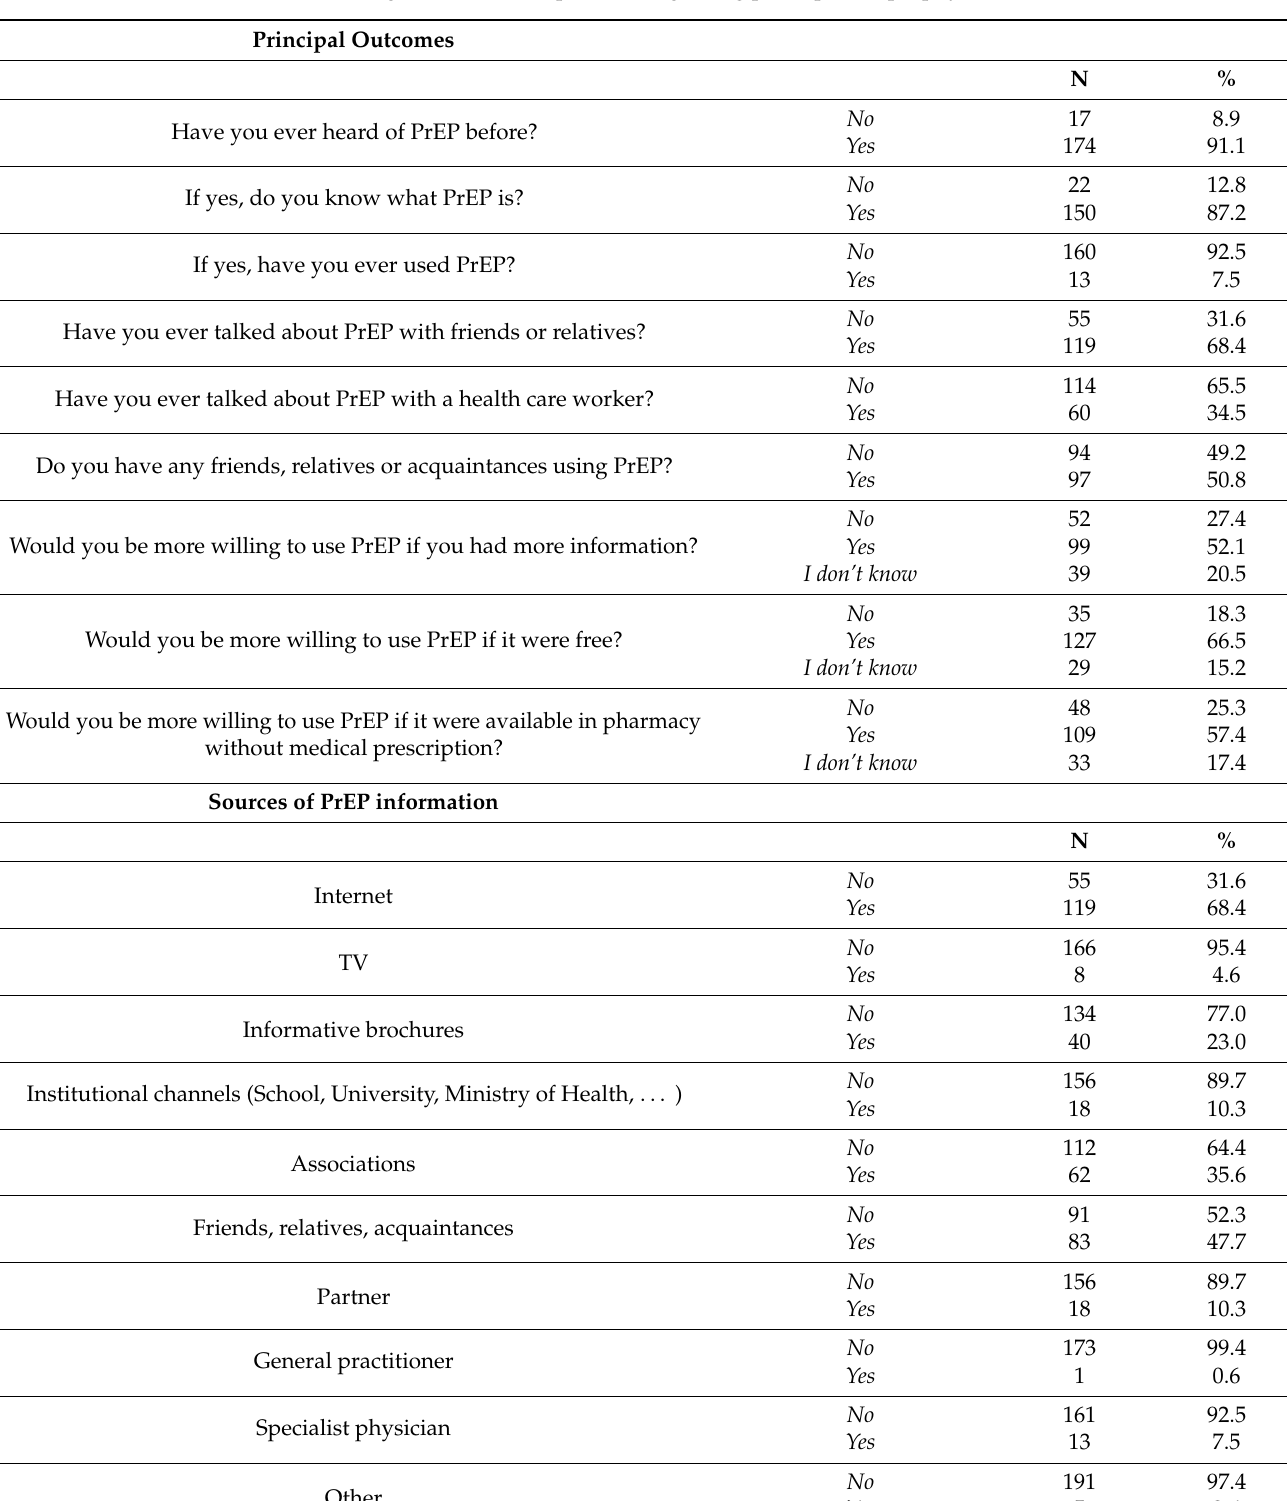
Table 3. Knowledge, attitudes and practices regarding pre-exposure prophylaxis